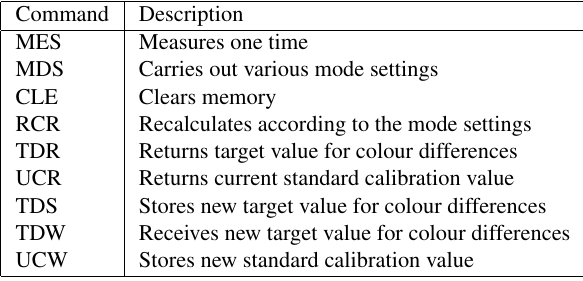
Table 1: Commands of CS-100A protocol